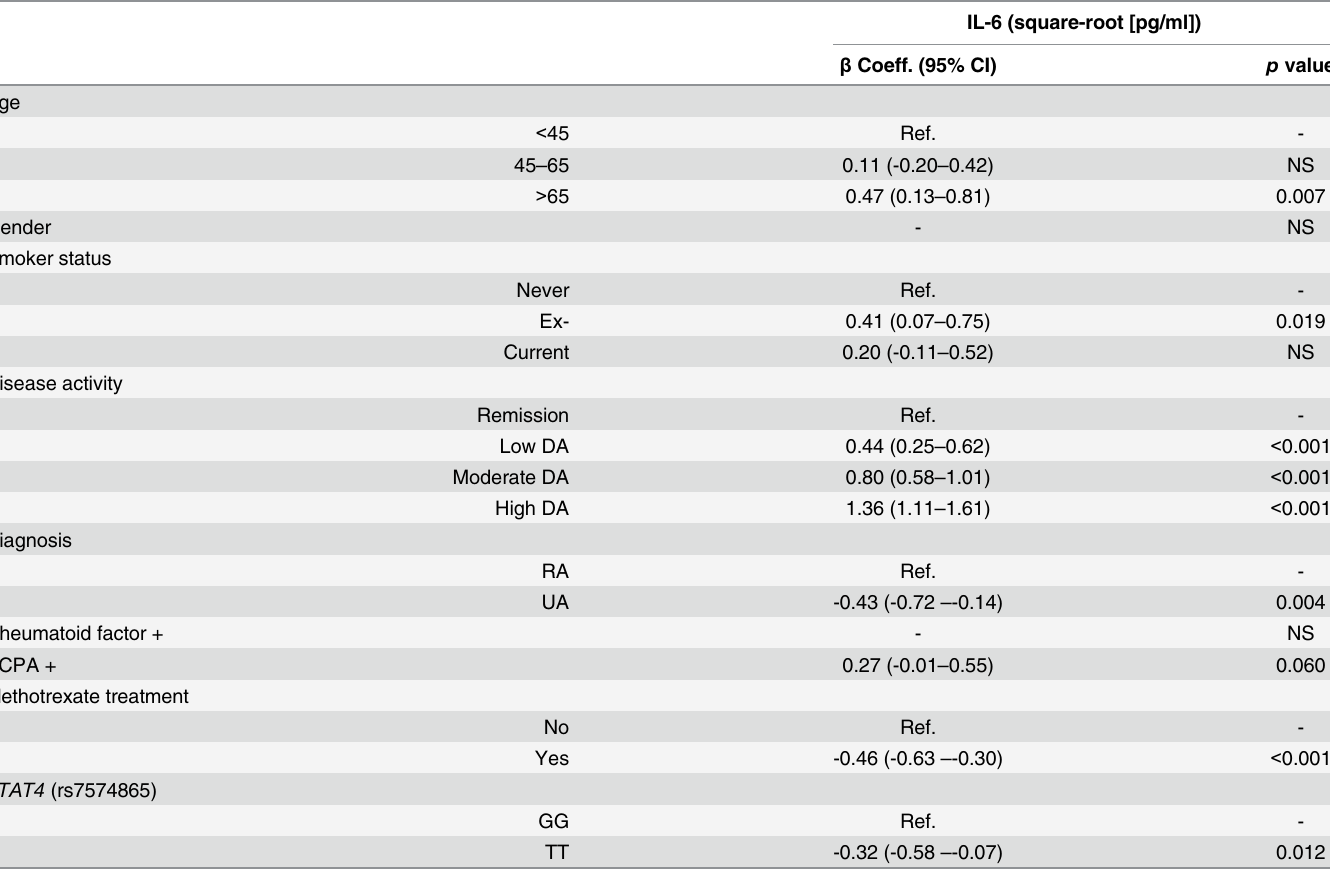
Table 4. Effect of different variables on IL-6 serum levels in patients with early